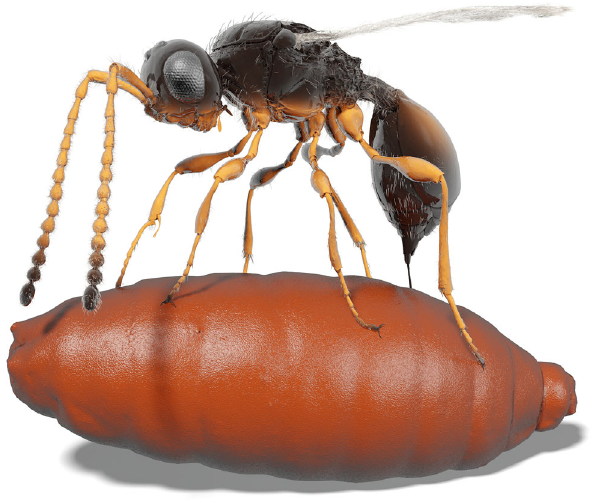
Fig. 3 Illustration of a female Xenomorphia resurrecta ovipositing into a puparium. The picture is directly based on tomography data of NMB F2875 (wasp; Figs. 1f, 2, 4a – m, Supplementary Figs. 1e, 2e, and 5b) and NRM-PZ Ar65767 (puparium; Supplementary Fig. 1aj). Colors and parts of pilosity are imaginary. Supplementary Movie 2 shows how the illustration was derived from original tomography